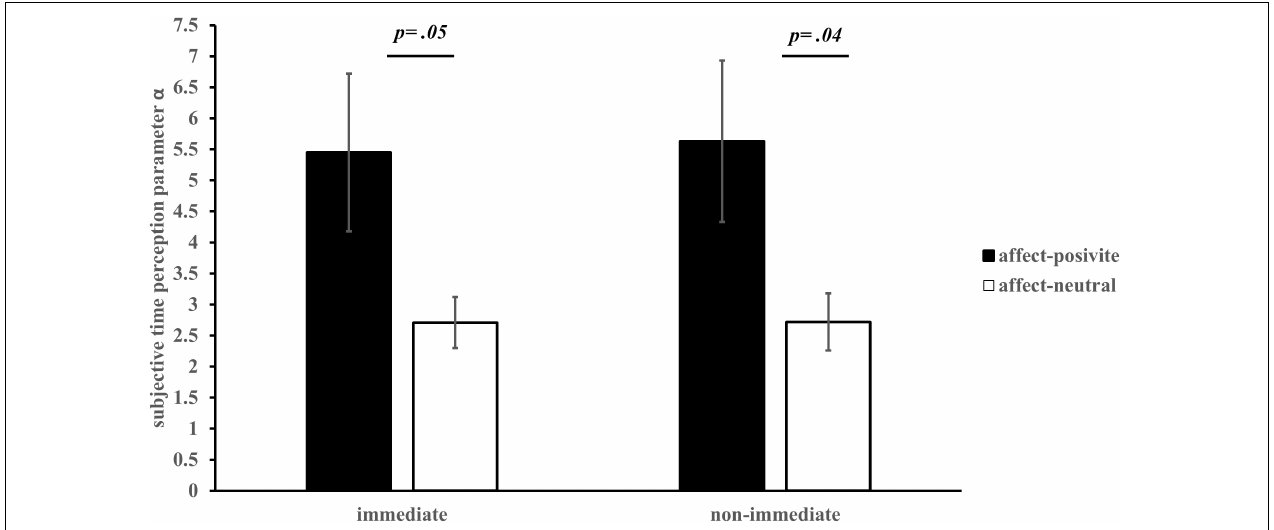
FIGURE 4 | Subjective time perception parameter α in different affect groups (M ± SE)